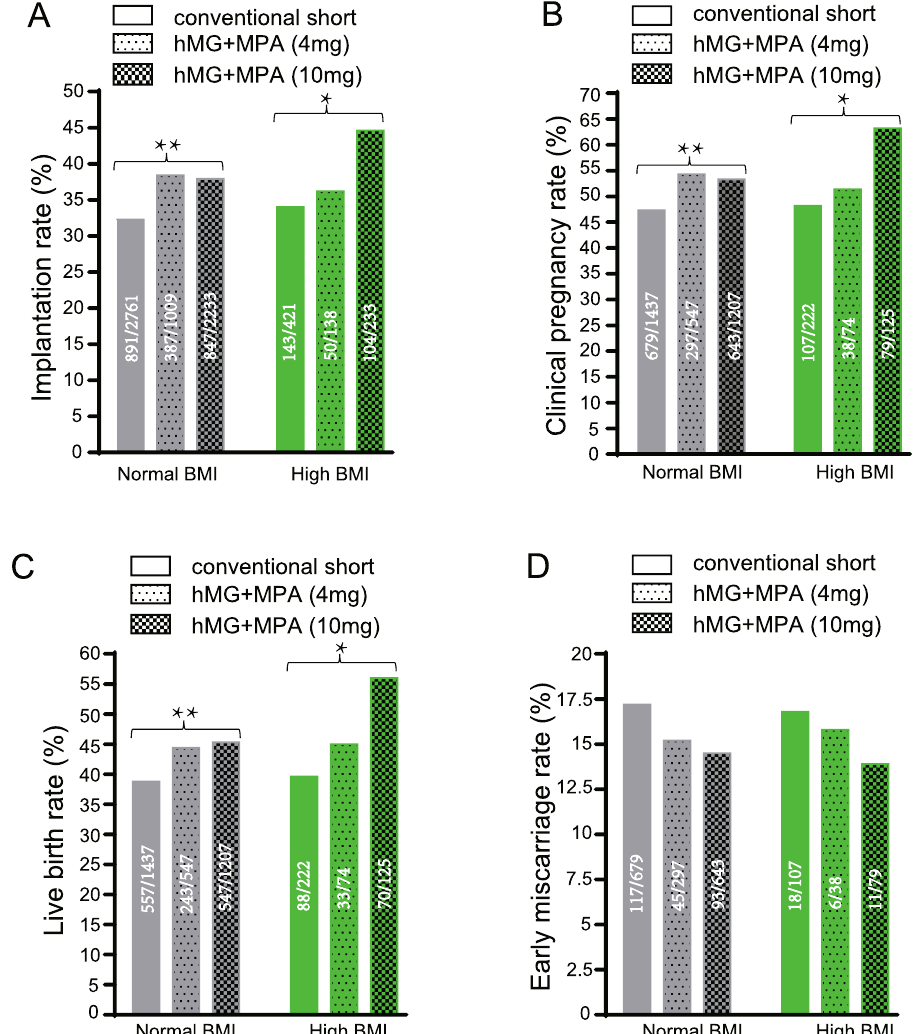
Figure 2. Comparison of implantation rate ( A ), clinical pregnancy rate ( B ), live-birth rate ( C ) and early miscarriage rate ( D ) across the three ovary stimulation groups according to female BMIs under FET. The raw data were shown in the figures and analyzed by Chi-square test. * p < 0.05, ** p < 0.01. Data are presented as mean ± standard error of the